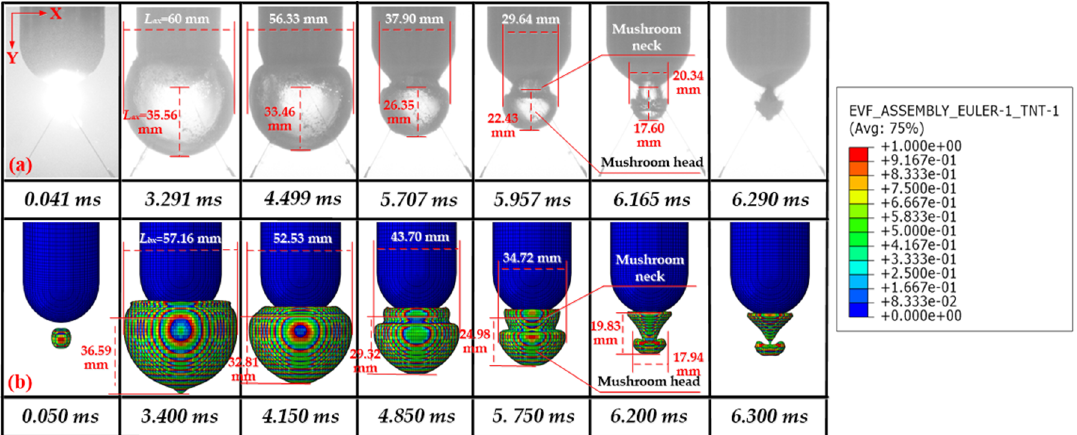
Figure 22. A pulsation chart of the first cycle of the bubble when γ = 0.33 and ζ = 1.2: ( a ) Electric spark bubbles generated by 400 V high-voltage electric discharge; ( b ) high-pressure cavitation bubbles simulated by ABAQUS/Explicit. According to Equation (16), when the bubble shapes were similar, the average error (cid:12) (cid:12) (cid:12) T (cid:12) between the experimental measurement time and the simulation time was 0.302 ms. The pulsation time of the first cycle of the bubble was 6.290 ms. of 6.290 ms and was